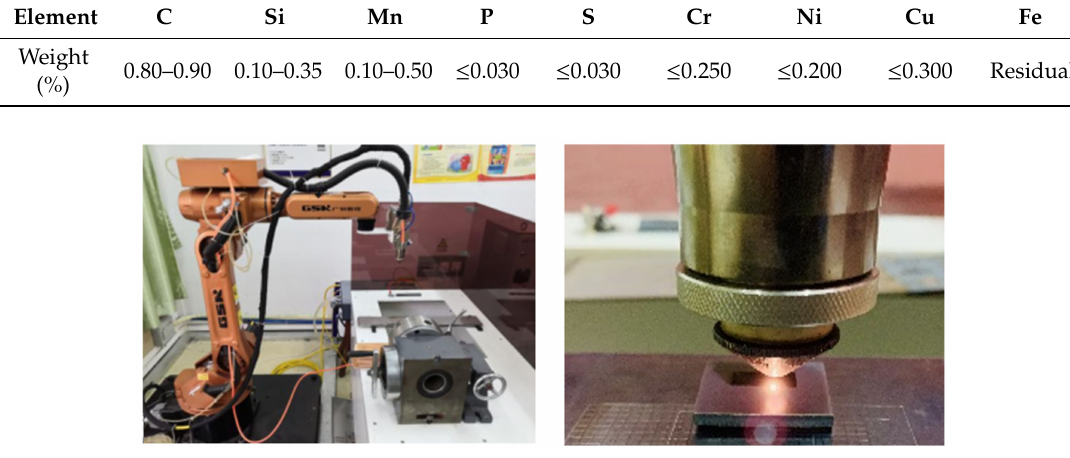
Figure 2. Laser manufacturing workstation of industrial robot. Table 2. Specific parameters of laser processing equipment.